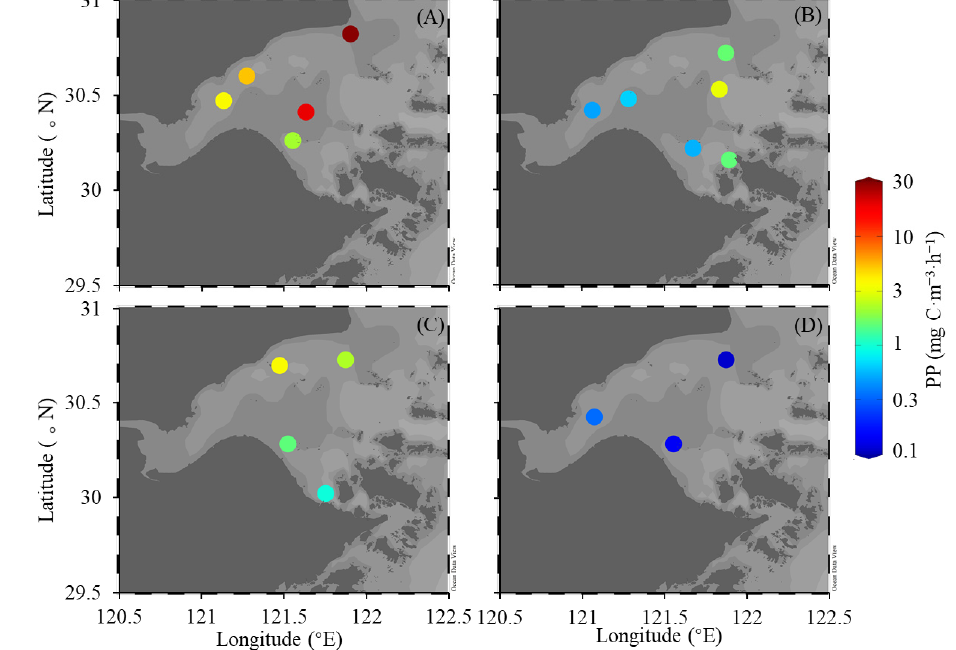
Figure 5. Spatial and temporal variations of PP (mg C · m − 3 · h − 1 ) in ( A ) July 2006, ( B ) December 2006, ( C ) April 2007 and ( D ) October 2007.